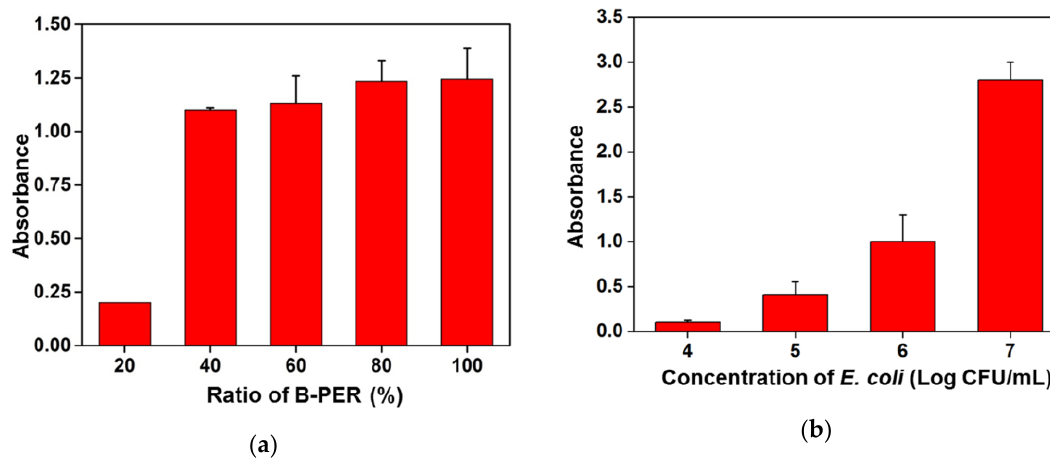
Figure 4. Optimization of enzymatic colorimetric change reactions for the sensitive detection of target bacteria: ( a ) Colorimetric response depending on the mixing ratio between B-PER and 5 mM PBS for the lysis of target bacteria; ( b ) Comparison of absorbance in the range 10 4 to 10 7 CFU / mL of target bacteria under the optimized experimental conditions.